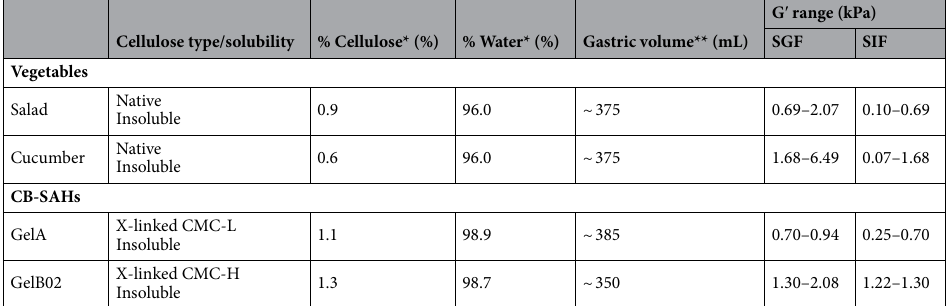
Table 2. Comparing basic compositional and structural features of common vegetables (salad and cucumber) and CB-SAHs (GelA and GelB02). The table compares values of cellulose and water content, gastric volume achieved by the recommended daily intake, and ranges of elastic modulus G ′ as measured in vitro in SGF and SIF. *Water and cellulose contents in vegetables are taken from the literature 11,37,38 . **Volume of vegetables is estimated based on the daily recommended amount (375 g) by the American Heart Association 39 , while the volume of CB-SAHs is calculated based on the daily dose (4.5 g) of a CB-SAH product (Gelesis100) according to its use in clinical setting 40